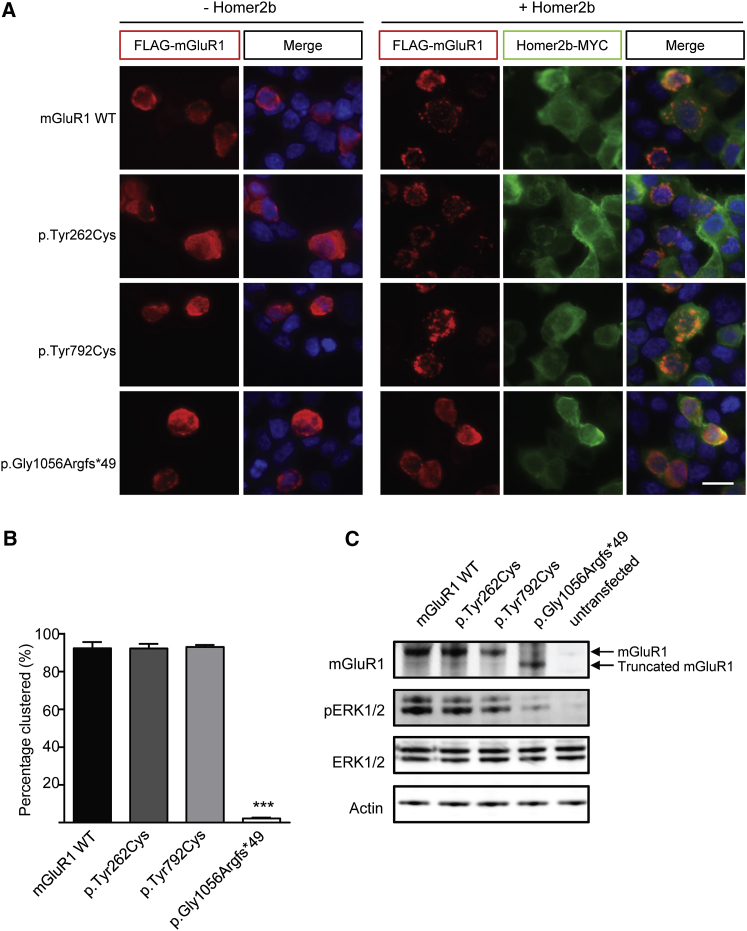
Deletion of the C-Terminal Domain of mGluR1 Affects Binding to Homer2bGRM1 expression constructs were generated using GRM1-Tango (Addgene plasmid 66387),15 into which a stop codon was inserted to prevent readthrough into the Tango element. The three dominant mutations were introduced by site-directed mutagenesis, and results were verified by Sanger sequencing. Constructs were transfected into HEK293FT cells (Invitrogen), using Lipofectamine 3000 (Thermo Fisher Scientific). 24 hr after transfection, cells were subjected to immunostaining using the following primary antibodies: mouse anti-FLAG (1:500; Sigma-Aldrich), rabbit anti-MYC (1:500; Abcam), and goat anti-mGluR1 (1:500; Santa-Cruz). Secondary antibodies: goat anti-mouse Alexa594 or Alexa488, goat anti-rabbit Alexa488, and donkey anti-goat Alexa594 (all 1:1,000; Life Technologies). Nuclei were stained with DAPI.(A) Cells transfected with FLAG-tagged mGluR1 only (left) show diffuse localization of wild-type (WT) and mutant mGluR1 (red). Co-transfection with MYC-tagged Homer2b results in clustering of WT mGluR1 and the p.Tyr262Cys and p.Tyr792Cys mutants but not the p.Gly1056Argfs∗49 deletion mutant. Scale bar: 20 μm.(B) Quantitative analysis of mGluR1-Homer2b clustering. For each biological replicate, 100 cells were counted. Bars show the mean of three biological replicates ± SEM. ∗∗∗p < 0.001 (one-way ANOVA, followed by Bonferroni’s multiple comparison test).(C) Western blot analysis of mGluR1 and components of its downstream signaling cascade. Protein extracts were prepared from cultured cells 24 hr after transfection, in ice-cold RIPA buffer (Thermo Fisher) containing 1× cOmplete, Mini, EDTA-free Protease Inhibitor Cocktail (Roche), 1× PhosSTOP (Roche), and 1 mM dithiothreitol (DTT), and analyzed by standard SDS-polyacrylamide gel electrophoresis and immunoblotting. Primary antibodies: rabbit anti-mGluR1 (1:200; Alomone Labs), rabbit anti-p44/42 MAPK (Erk1/2) and rabbit anti-phospho-p44/42 MAPK (Erk1/2) (both 1:1,000; Cell Signaling Technologies), and mouse anti-actin (1:1,000; Abcam). HRP-conjugated secondary antibodies: donkey anti-rabbit and sheep anti-mouse (both 1:10,000; GE Healthcare). A decrease in phosphorylation of Extracellular Signal-Related Kinase 1/2 (ERK1/2) was observed in cells transfected with the mGluR1 p.Gly1056Argfs∗49 mutant, indicating disruption of mGluR1 downstream signaling events.